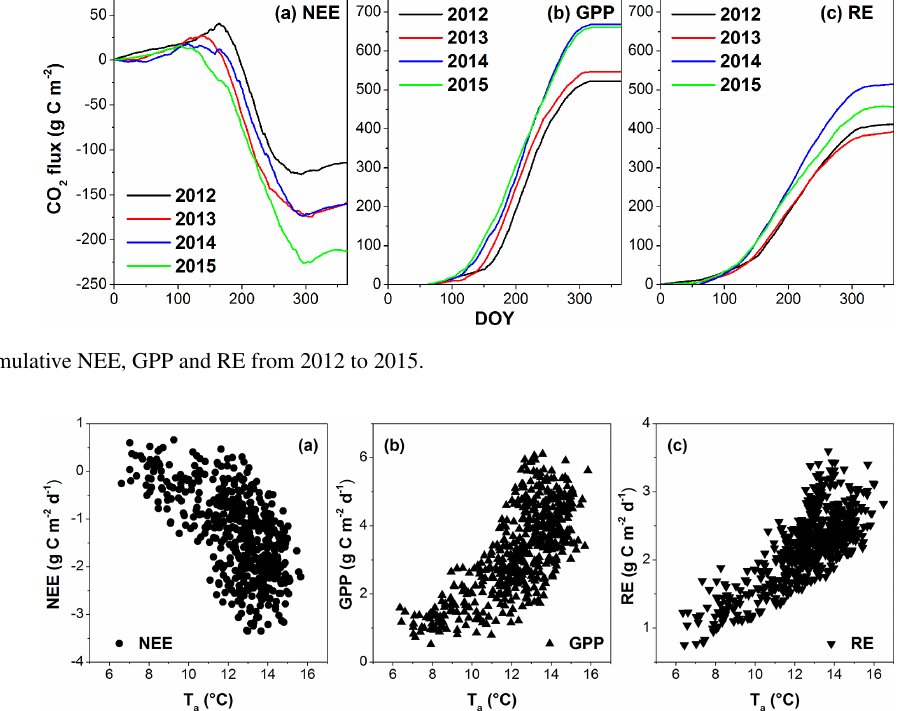
Figure 6. Relationships between (a) NEE and T a , (b) GPP and T a and (c) RE and T a for the wet seasons from 2012 to 2015.